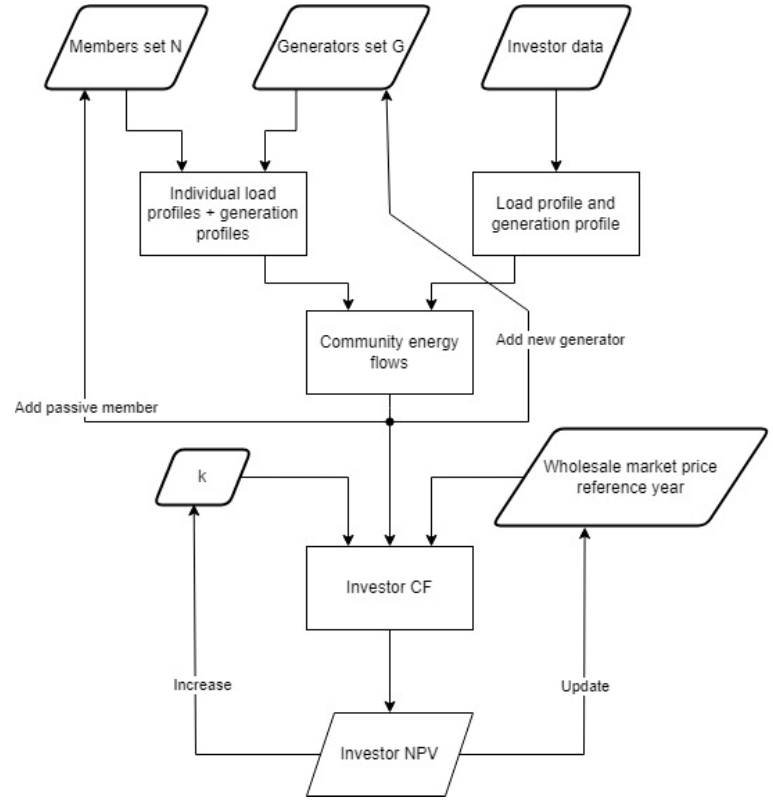
Figure 1. Sensitivity approach flow chart.